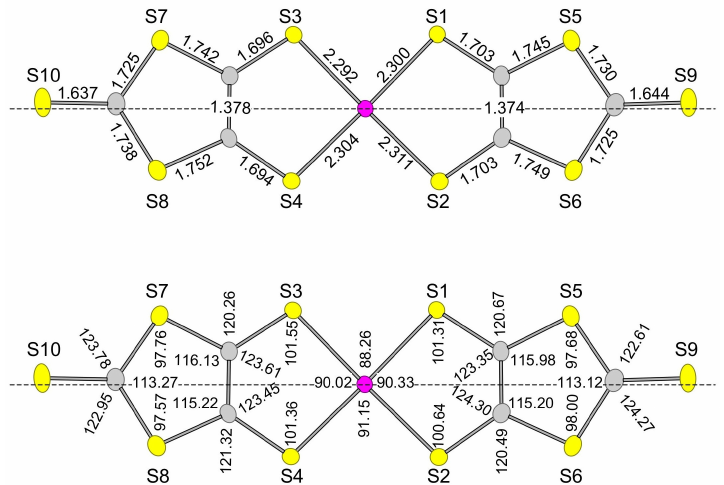
unit in the Et 2